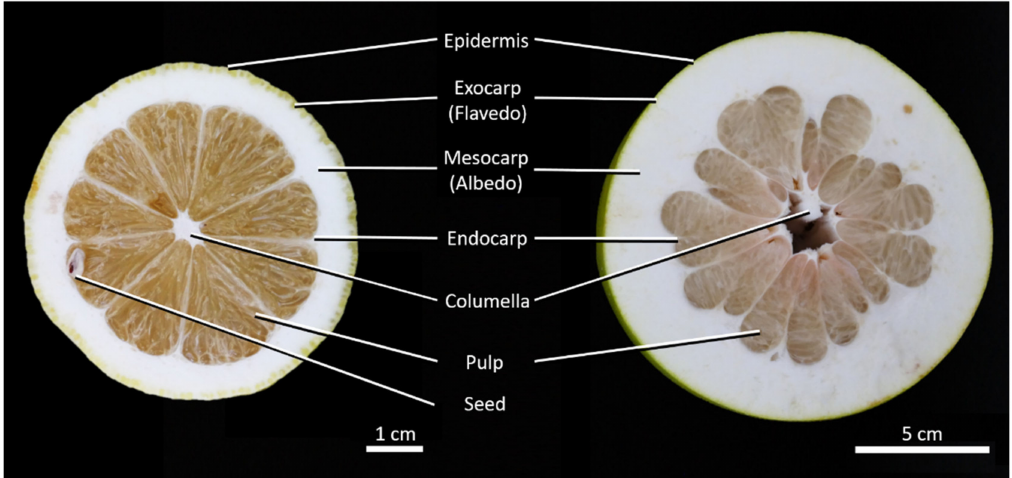
Figure 1. Cross section of Citrus × limon ( left ) and Citrus maxima ( right